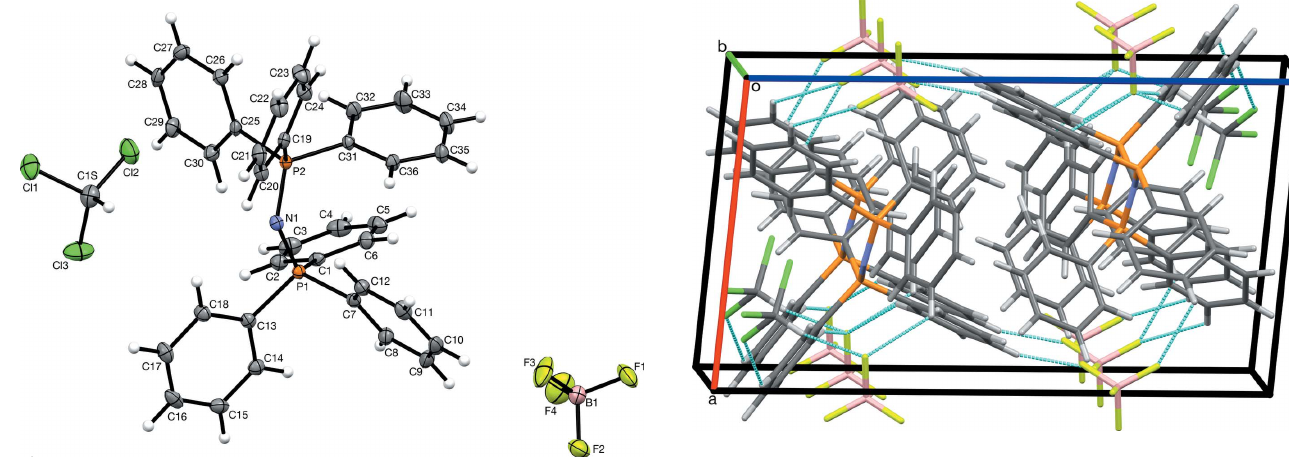
Figure 2 Overall packing viewed along the b -axis showing representative C—